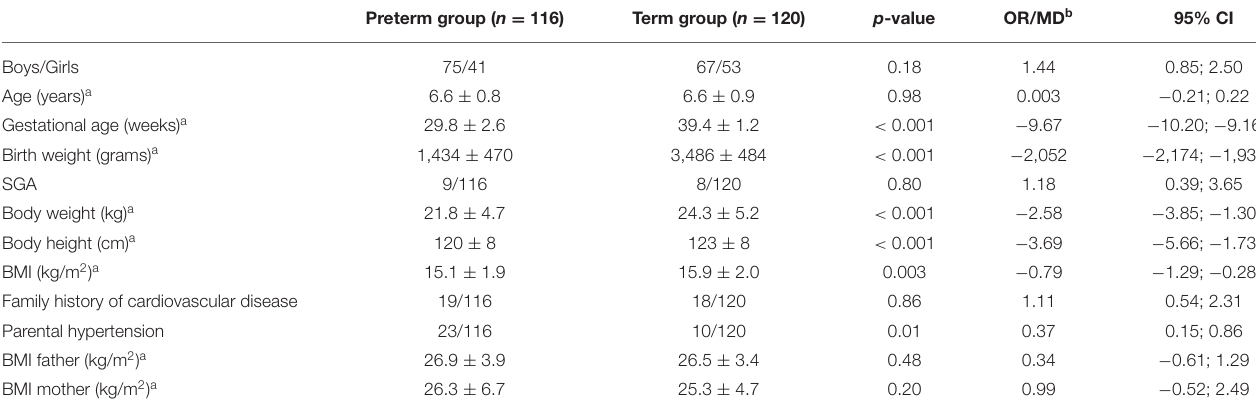
TABLE 1 | Baseline characteristics of children born preterm and children born at